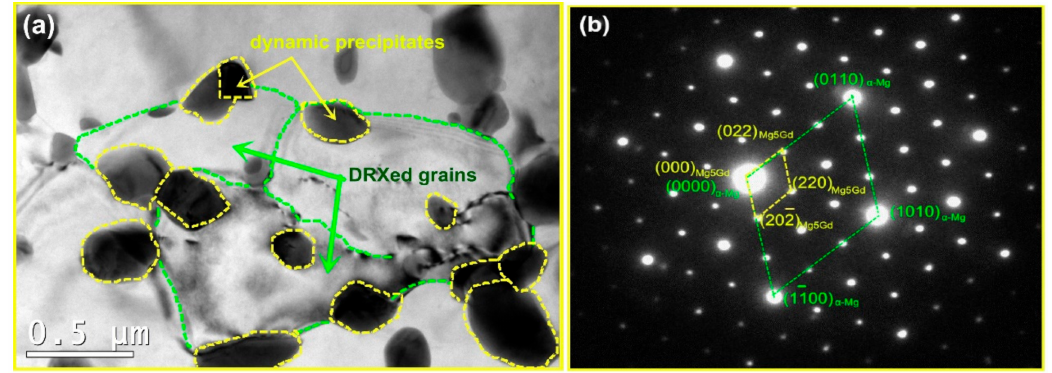
Figure 3. The optical micrograph ( a ) and BSE image ( b ) of the Mg–8.08Gd–2.41Sm–0.30Zr alloy . ε = 0.002 s − 1 and T = 350 ◦ C. deformed under the conditions of